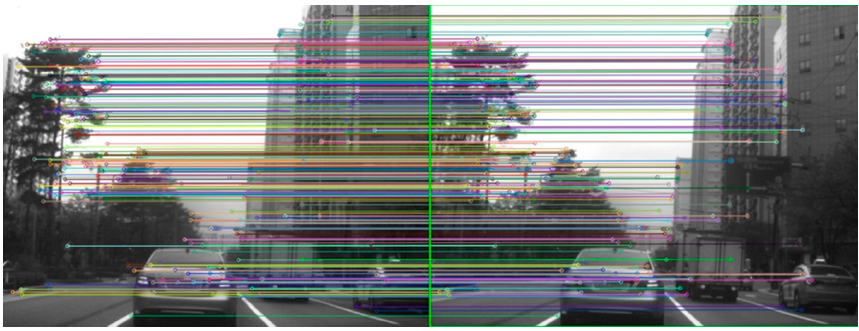
Figure 4. Feature points and matching relations example.